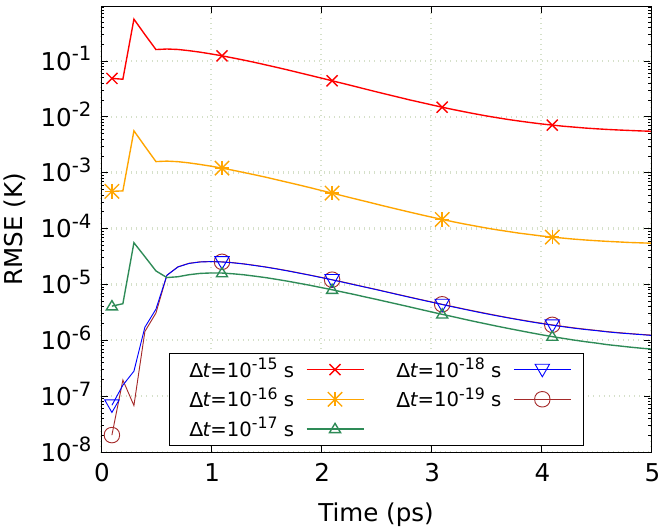
Figure 4. Root mean square error in electronic temperature depending on time for different time steps. The calculation with time step of 1 × 10 − 20 s was used as a